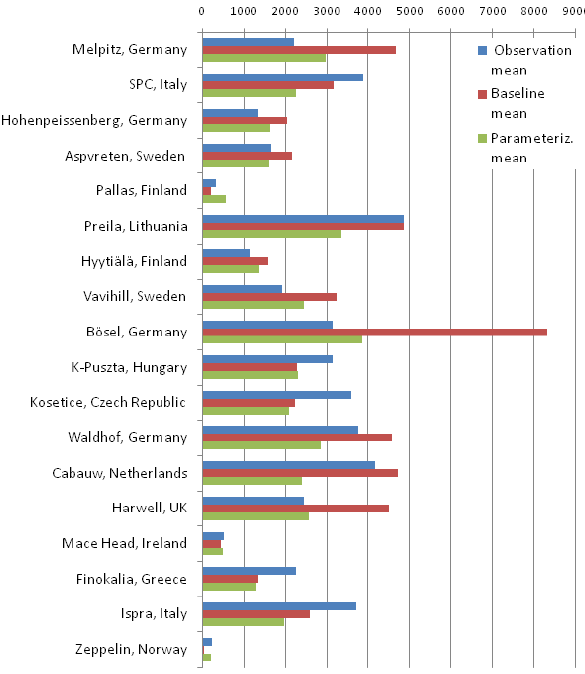
Fig. 7. Mean observed and predicted potential CCN ( D p > 50nm) concentrations at the 3 measurement sites (measurement data from the time periods indicated in the text) and at 15 EUCAARI sites (measurement data for April 2008 and 2009). Note that the model is run for April 2000. Units are cm − 3